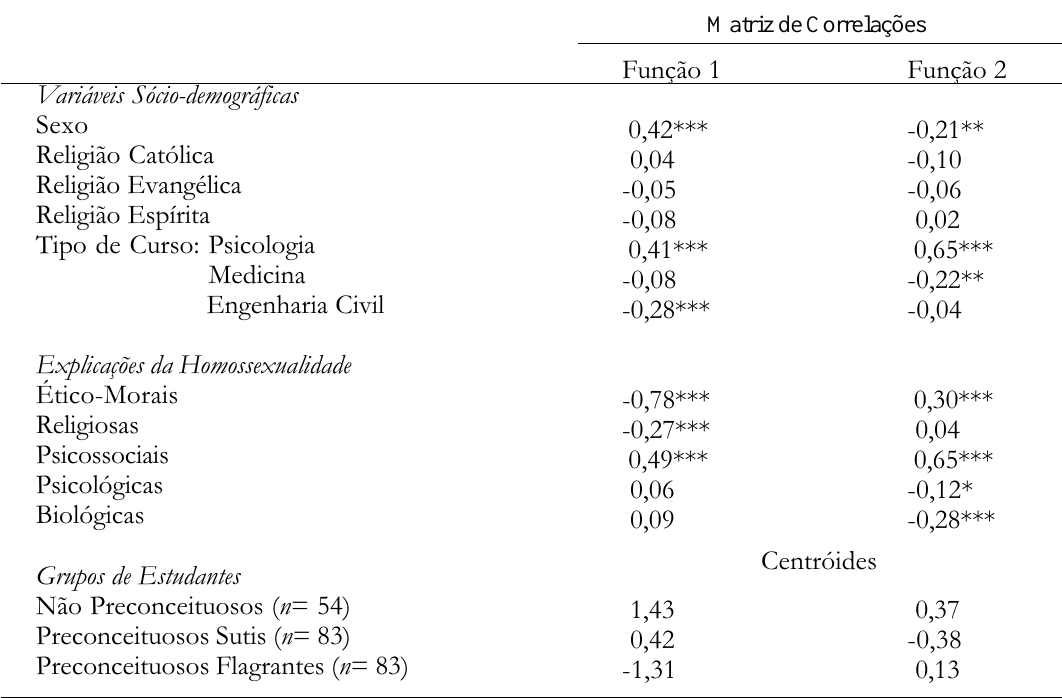
Tabela 5. Resultados das Fun(cid:231)ıes Discriminantes Aplicadas aos TrŒs Grupos de Estudantes (Nªo Preconceituosos, Sutis e